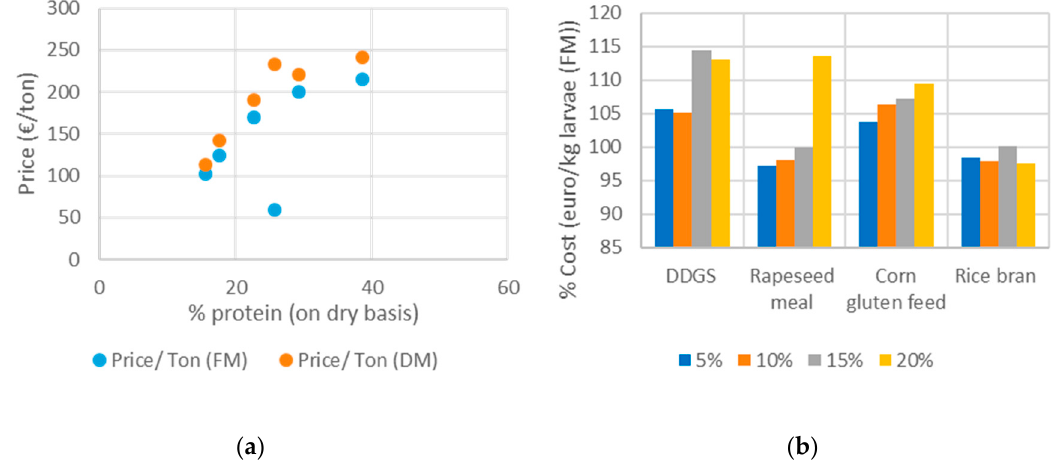
Figure 5. ( a ) Correlation between relation of protein content of side-streams and their price (in euros) on product basis (fresh matter, FM) and dry matter (DM) basis. ( b ) Effect on the cost price of side-stream inclusions in the reference diet compared to the cost price of the reference diet (100% cost).